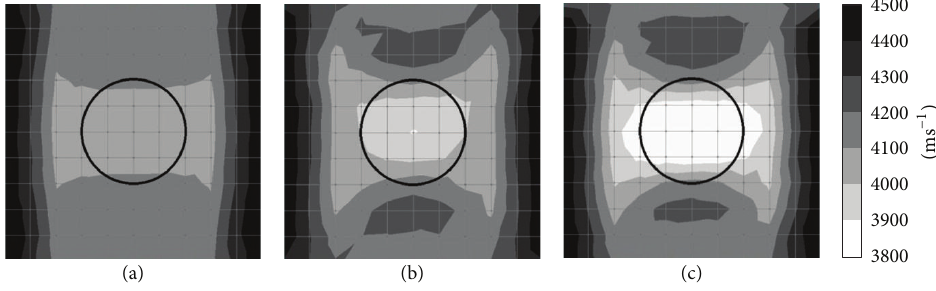
Figure 9: Tomograms simulated by 100 elements: (a) 0% void; (b) 50% void; and (c) 100%